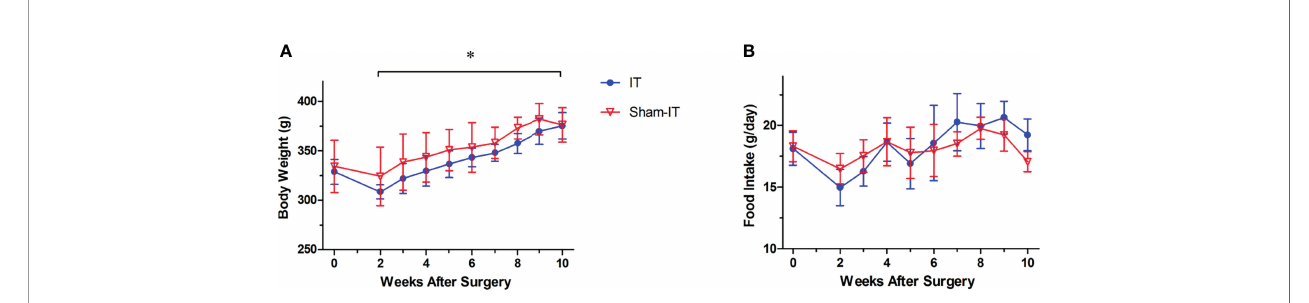
FIGURE 2 | Body weight and food intake after operation. N = 6 in each group. * p < 0.05. (A) Body weight. IT group exhibited less body weight than sham group after surgery (two-way ANOVA: p < 0.001). (B) Food intake. No difference was found in food intake between the two groups (two-way ANOVA: p